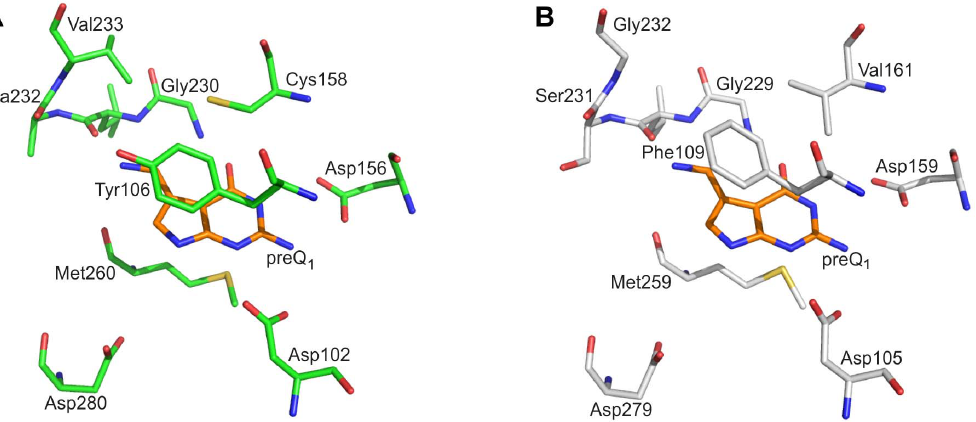
Figure 4. Substrate base binding pocket of Z.mobilis Tgt and modelled human Tgt. A) Detail of Z. mobilis Tgt ? preQ 1 complex crystal structure (PDB-code: 1p0e ) showing the active site with the bound substrate in stick representation. Carbon atoms of protein residues are coloured in green, those of preQ 1 in orange. B) Homology model of human Tgt created with the Z. mobilis Tgt crystal structure as a template. The close up shows active site residues (carbon atoms in grey) superimposed with preQ 1 (carbon atoms in orange) as present in 1p0e . The coordinates of the homology model are provided within the Supporting Information (Coordinates S1).